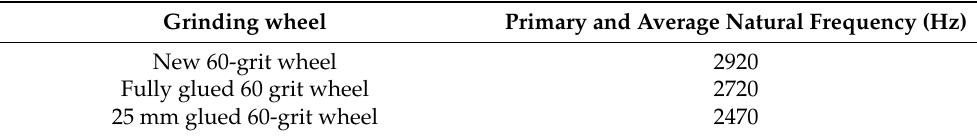
Table 5. Average and primary natural frequency of 60-grit medium-grade wheels after 60 impact hammer tests.